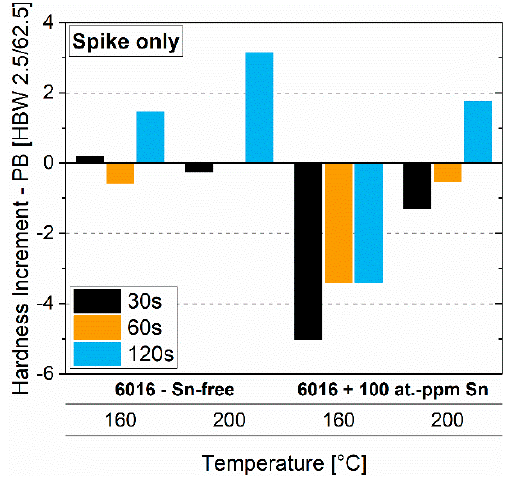
Figure 9. Paint-bake response (185 °C, 20 min, no pre-deformation) of samples treated solely with Spike I at 160 °C and 200 °C (EN-AW-6016 Sn-free and EN-AW-6016 + 100 at.-ppm Sn).